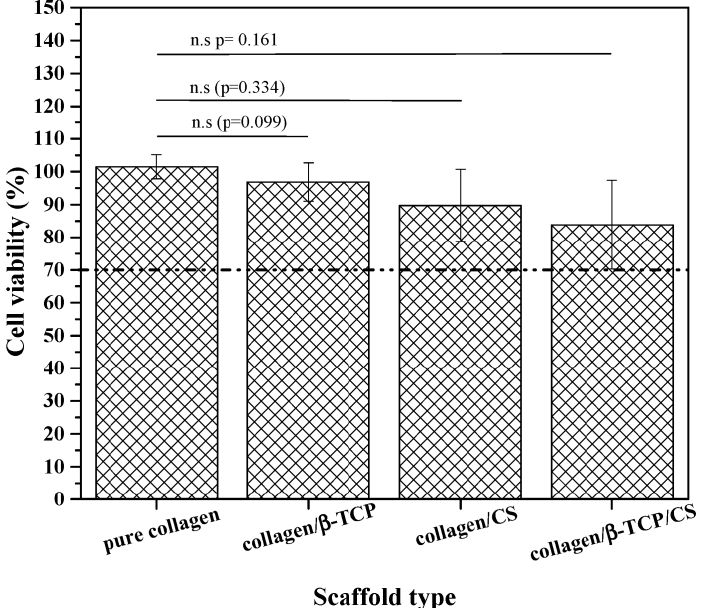
Figure 7. Cell viability of pure collagen scaffold and collagen/ β -TCP, collagen/CS, and collagen/ β - TCP/CS composite scaffolds derived from MC3T3-E1 cells after incubation for 3 d. n.s: not significant ( p > 0.05).